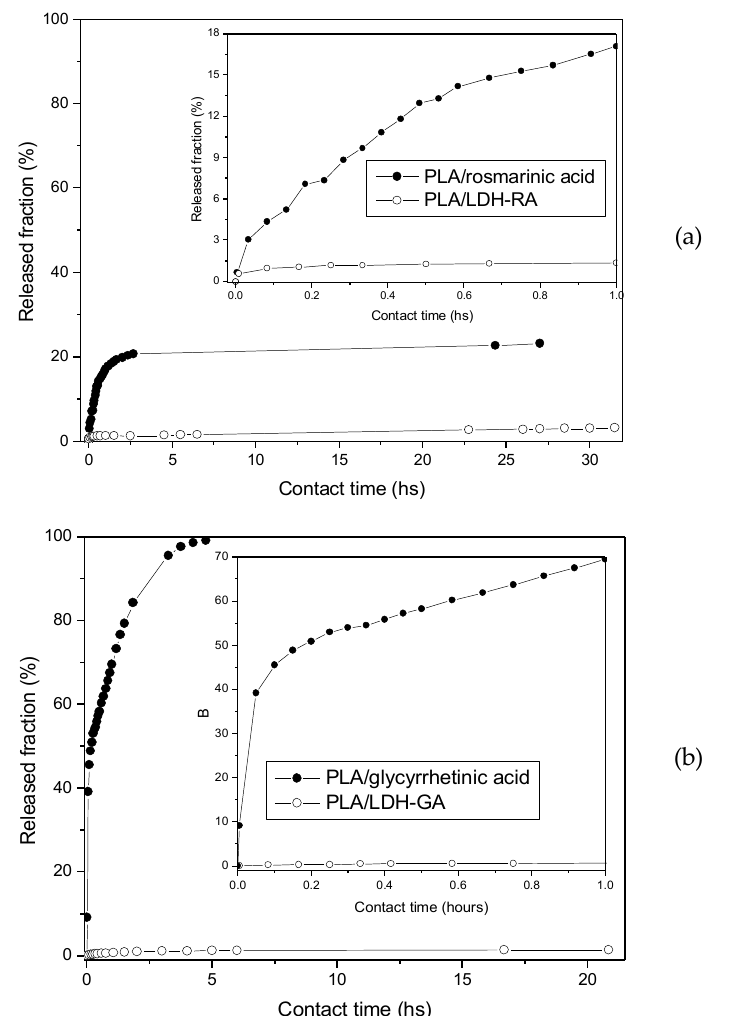
Figure 11. Released fraction of active molecules from PLA/rosmarinic acid and PLA/LDH-RA films ( a ) and from PLA/glycyrrhetinic acid and PLA/LDH-GA films ( b ) as a function of contact time. The inset shows the curves for the first hour of contact between the film and the EtOH/H 2 O (95/5 v / v ) solution.